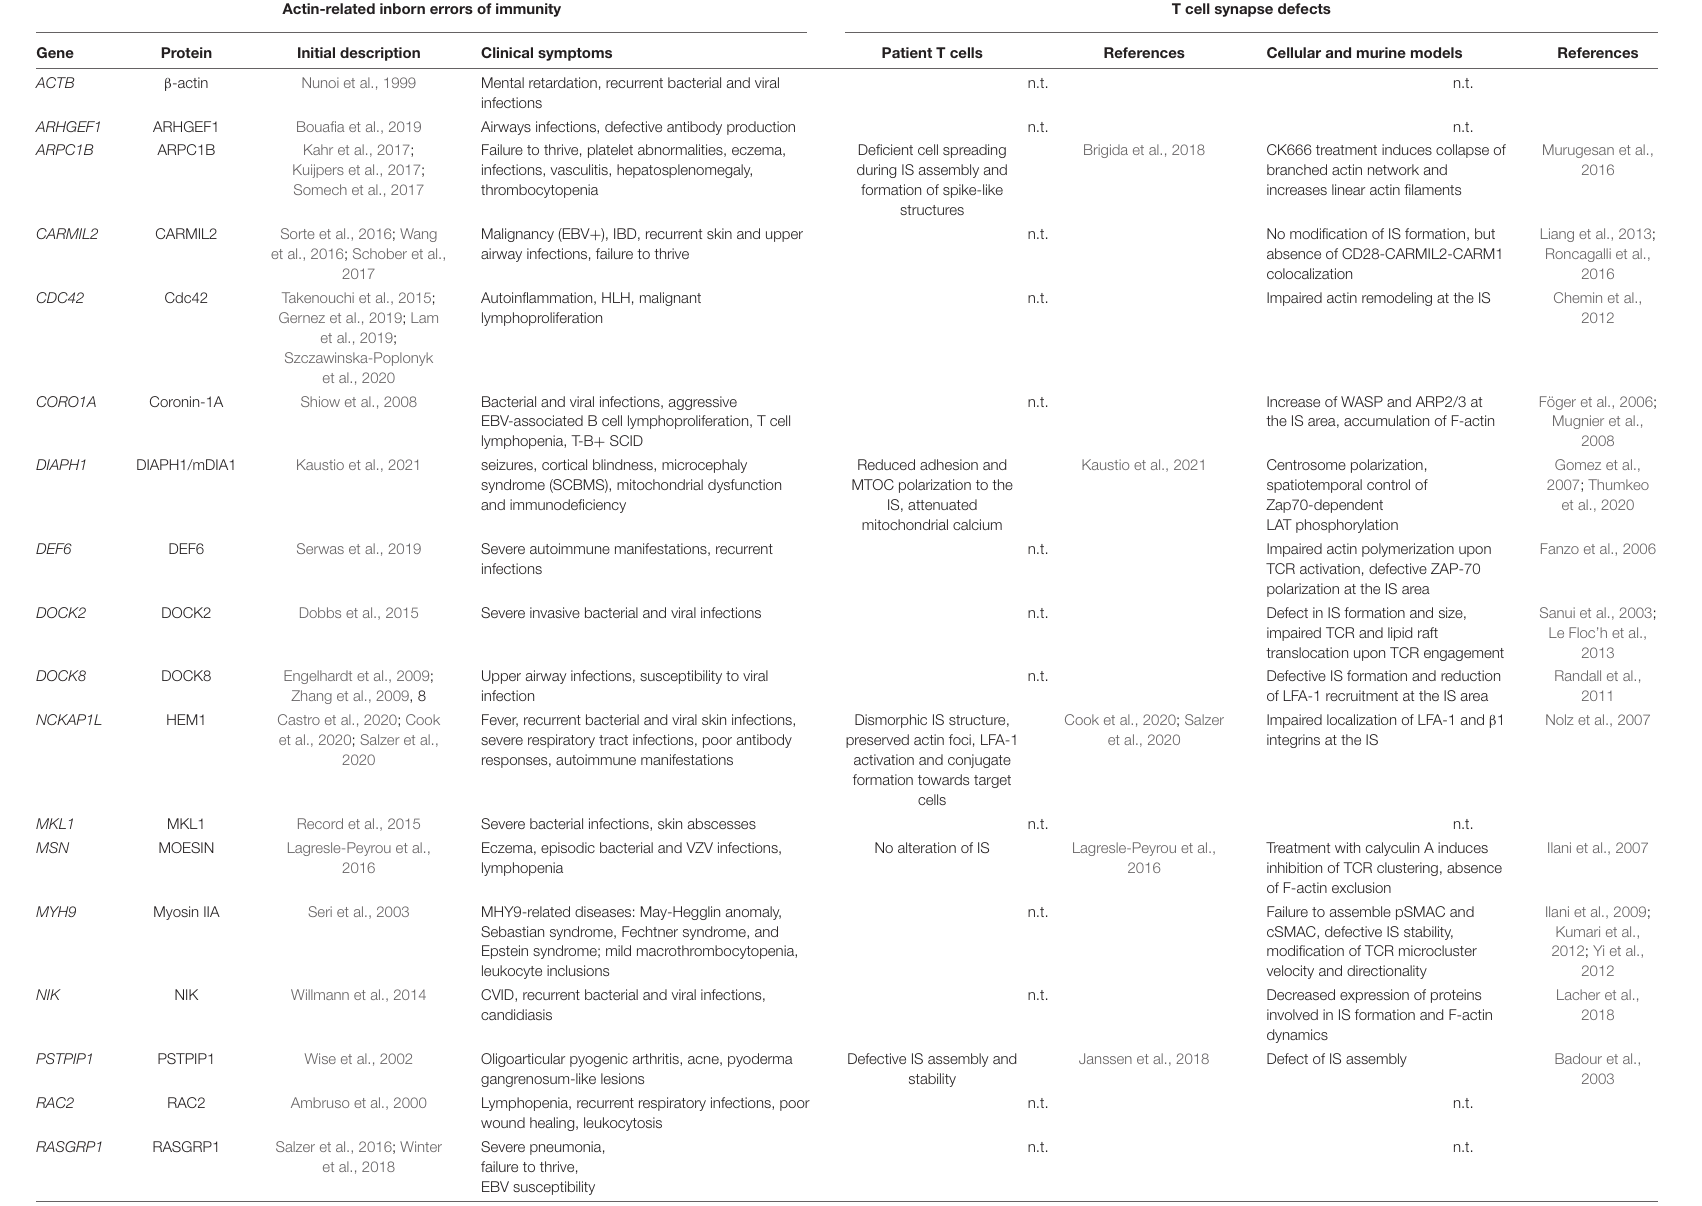
TABLE 1 | Inventory of immune-related actinopathies and associated T cell synapse